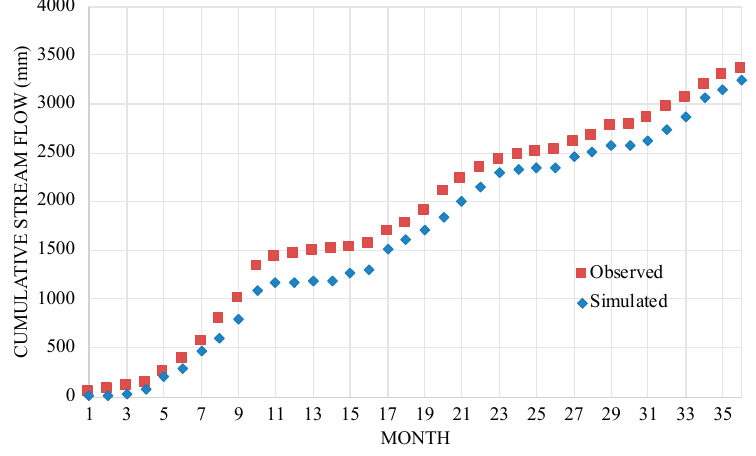
Figure 8. Thirty-six-month (2010–2012) cumulative streamflow from the Guanajibo Watershed: observed vs. GOES-PRWEB-estimated RO + DP.